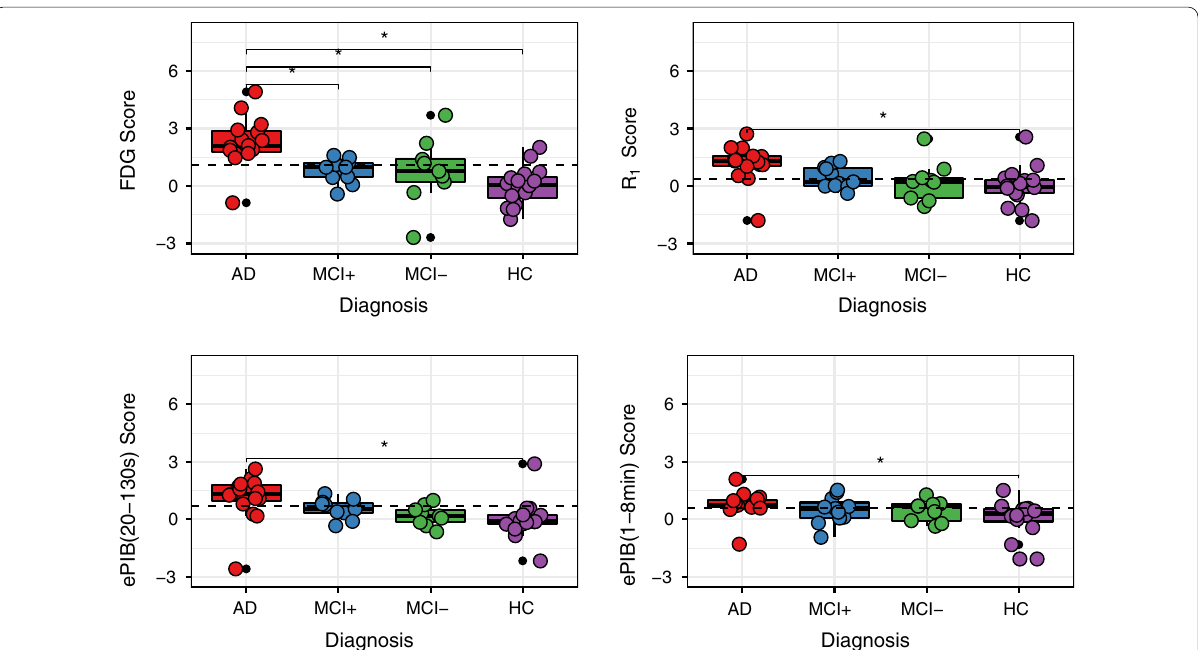
Fig. 4 Distribution of Scores per Method . Distribution of the subjects’ normalized scores from FDG (top left), R 1 (top right), ePIB(20–130 s) (bottom left), and ePIB(1–8 min) (bottom right). Boxes represent the interquartile range of distribution, with the median per group showing as a full line, the whiskers expanding up to 1.5 times the interquartile range, and the outliers are presented as black dots. Coloured circles represent individual subjects’ scores within the groups. AD patients are depicted in red, MCI , in blue; MCI , in green; and HC subjects, in purple. The dashed lines + − correspond to the threshold for classifying subjects as AD patients, and the stars represent the differences between groups that are